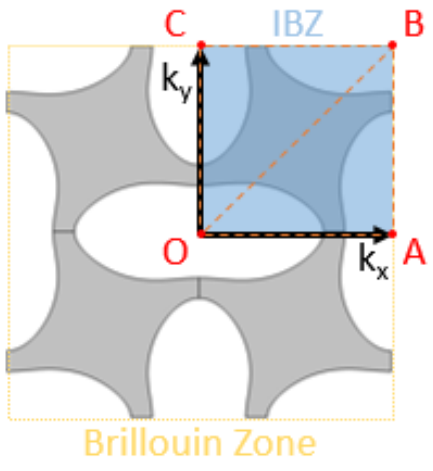
Figure 9. BZ and IBZ depiction for a 2D